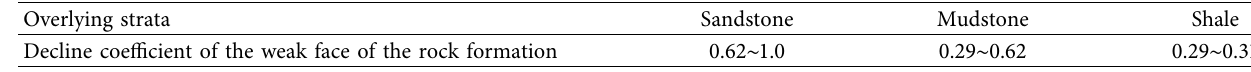
Table 2: Rock layer weak surface coefficient